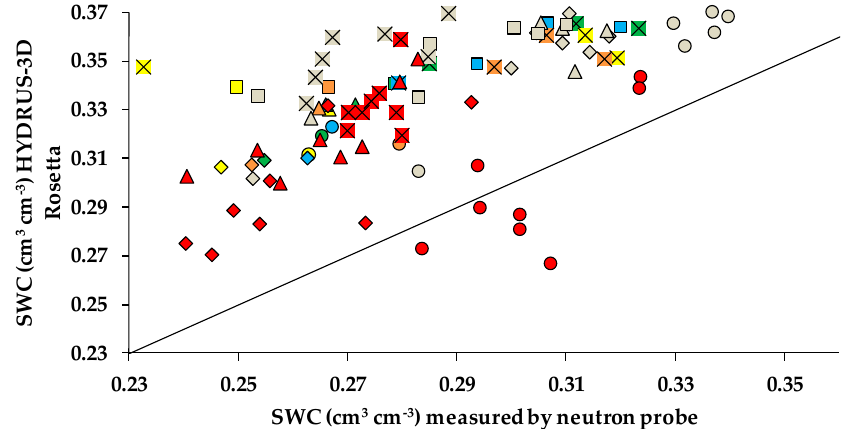
Figure 4. Soil water content (SWC) simulated with HYDRUS-3D parameterized from Rosetta versus average measurements by neutron probe on 8 different dates in the 2018 irrigation season. Colors indicate access tubes (green = A, yellow = B, blue = C, orange = D, grey = E and red = F) and shapes indicate different depths ( = 20 cm, = 40 cm, ∆ = 60 cm, ☐ = 80 cm and ✕ = 100 cm).